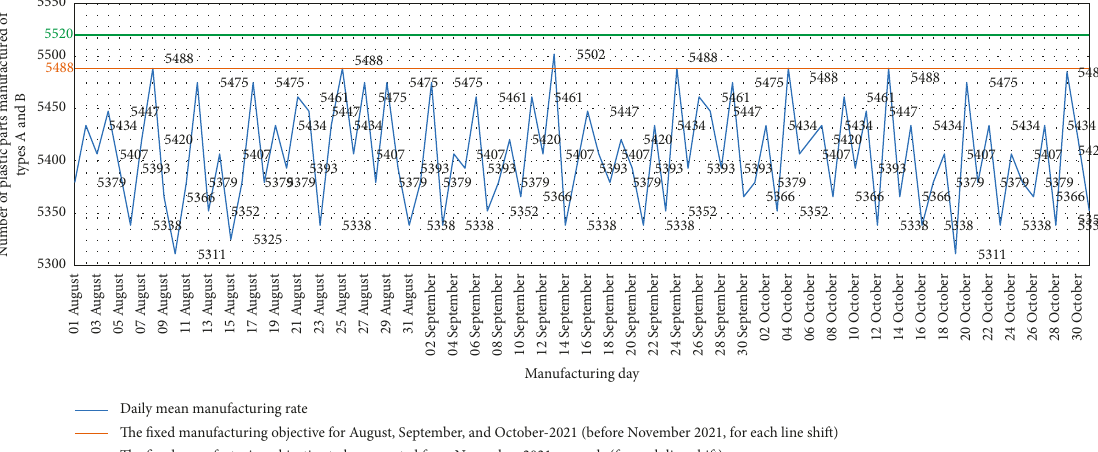
Daily mean manufacturing rate The fixed manufacturing objective for August, September, and October-2021 (before November 2021, for each line shift) The fixed manufacturing objective to be respected from Novembre-2021 onwards (for each line shift) Figure 4: Daily mean manufacturing rate during August, September, and October 2021 and fixed manufacturing objectives before and from November 2021 (the former manufacturing objective and the new one).